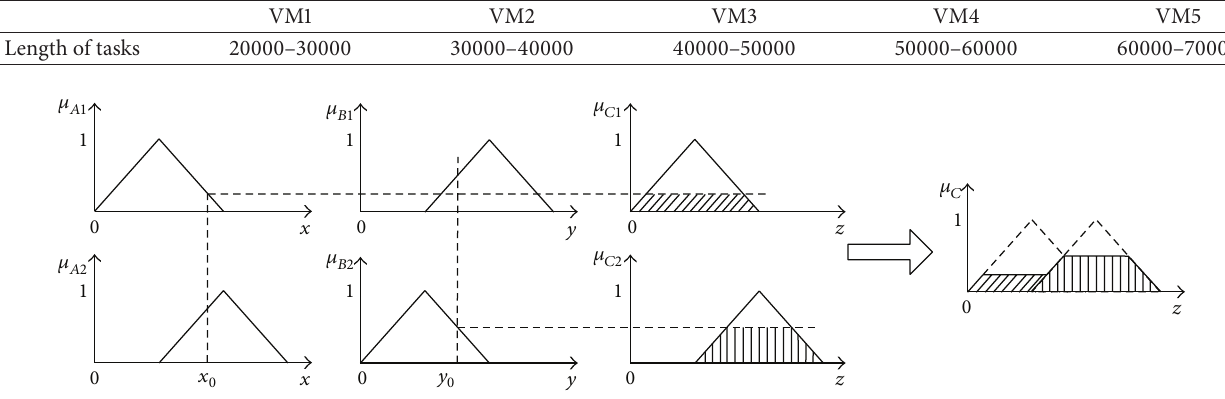
Figure 6: The graphic representation method of max-min inference